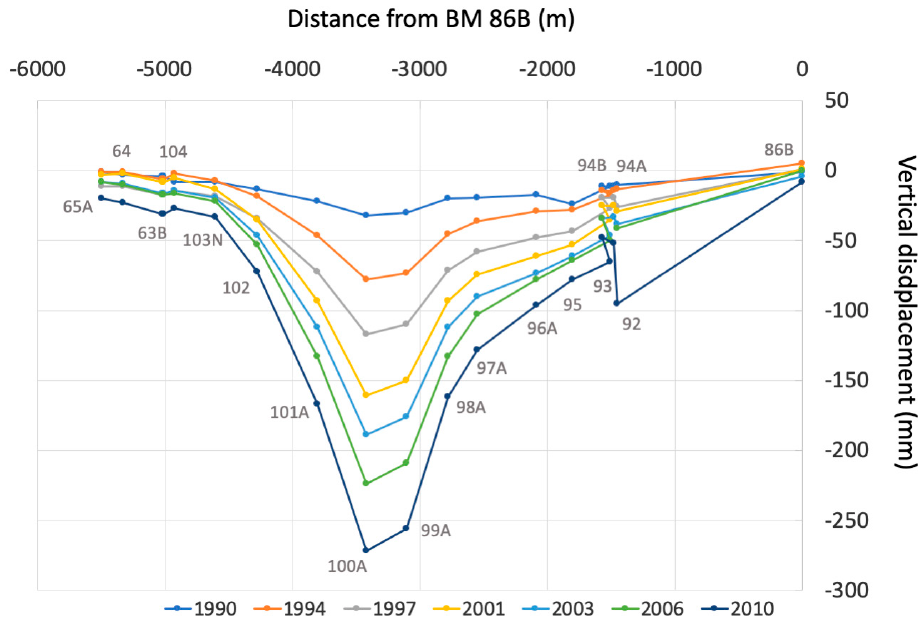
Figure 6. Vertical displacement measured at benchmarks along the “Borbonica” levelling line [32], during the surveys from 1987 to 2010. The horizontal axis reports the linear distance from the benchmark 86B. For location of benchmarks see Figure 1.